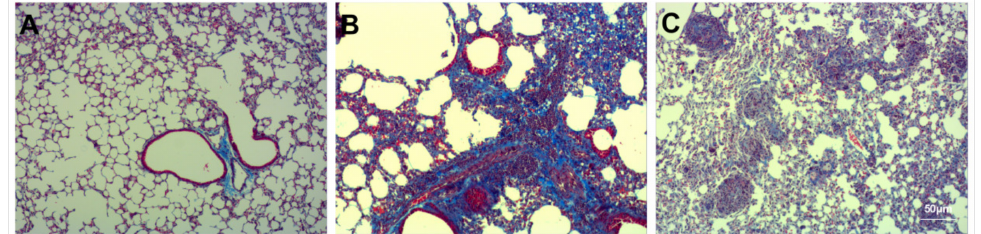
Figure 4. Detection of pulmonary fibrosis: ( A ) Con group; ( B ) Bl group; ( C ) Bl + MSC group; Mason staining revealed the degree of pulmonary fibrosis. ( A – C , 200 × magnification).